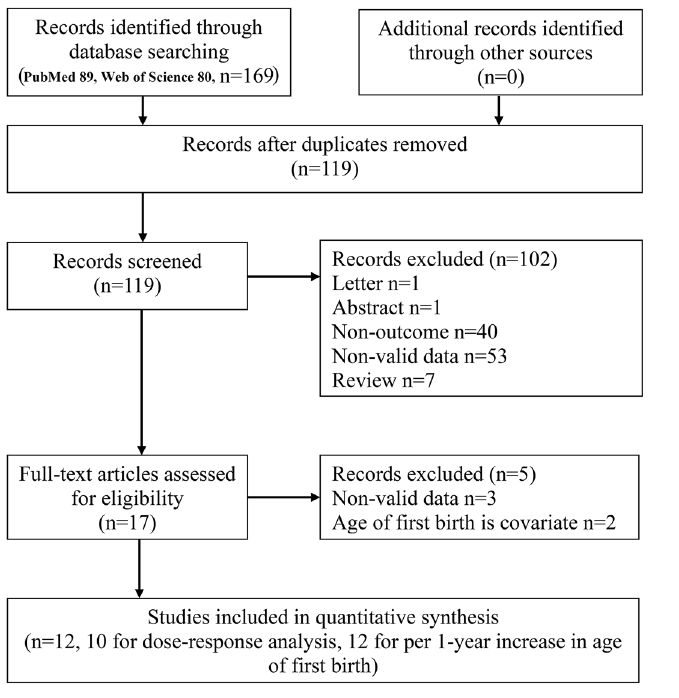
Figure 1. Flow-chart of study